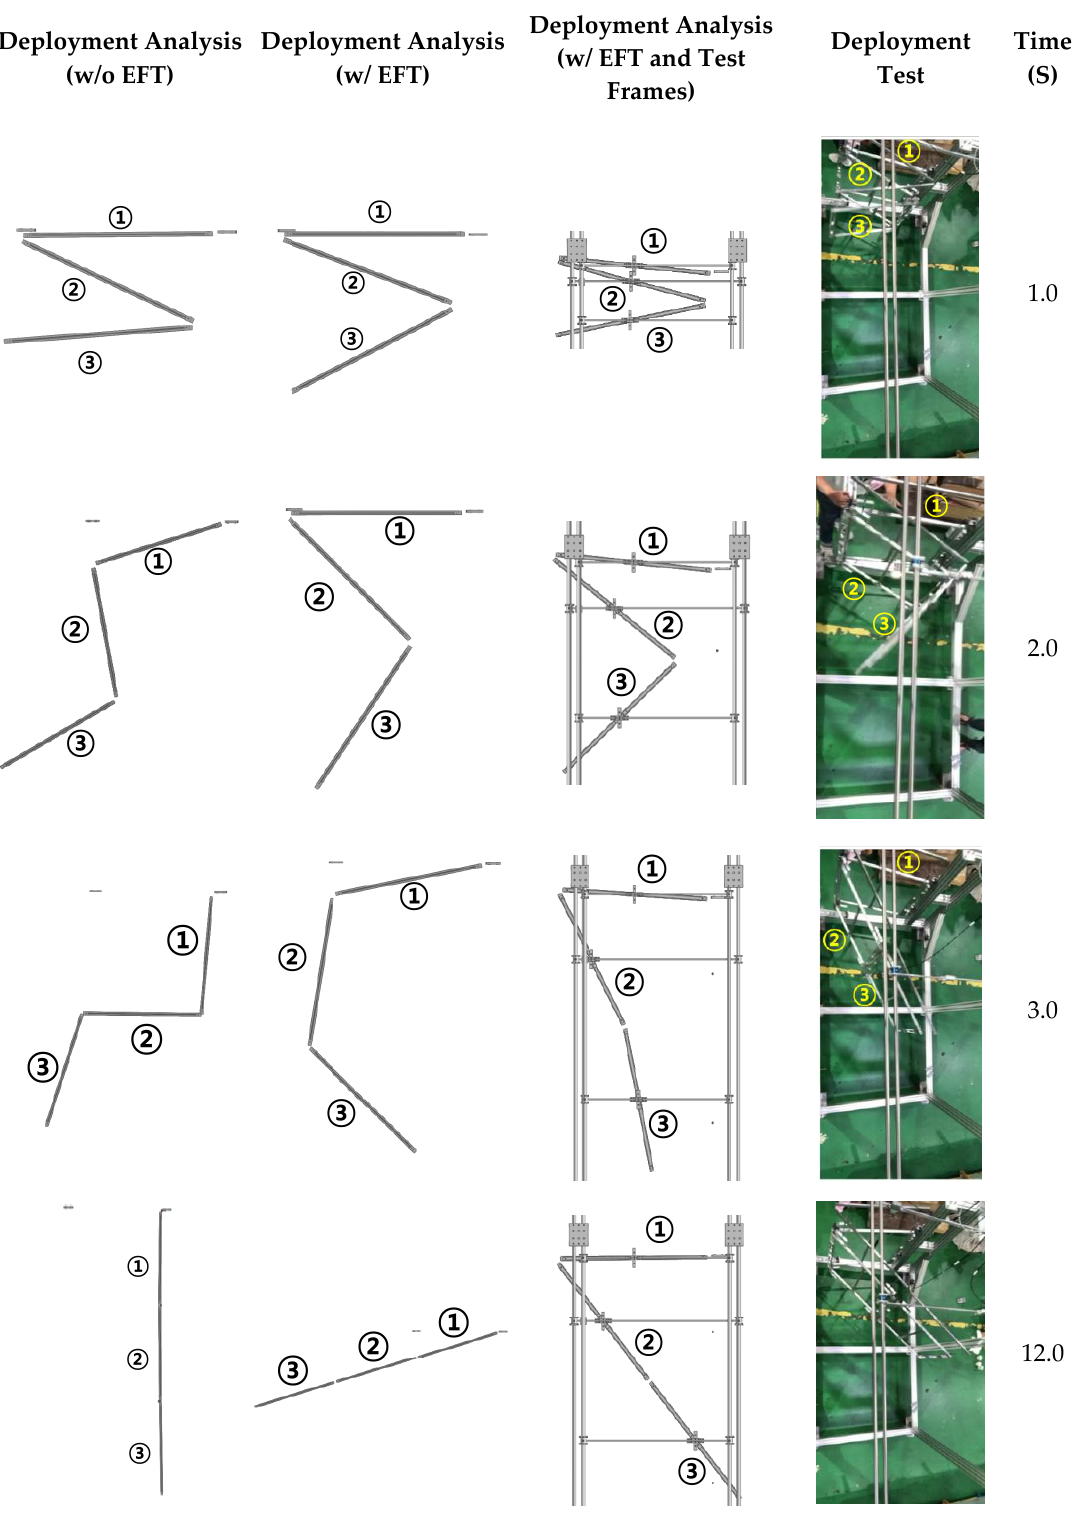
Figure 13. Comparison of the rotation angle history for T02 case.